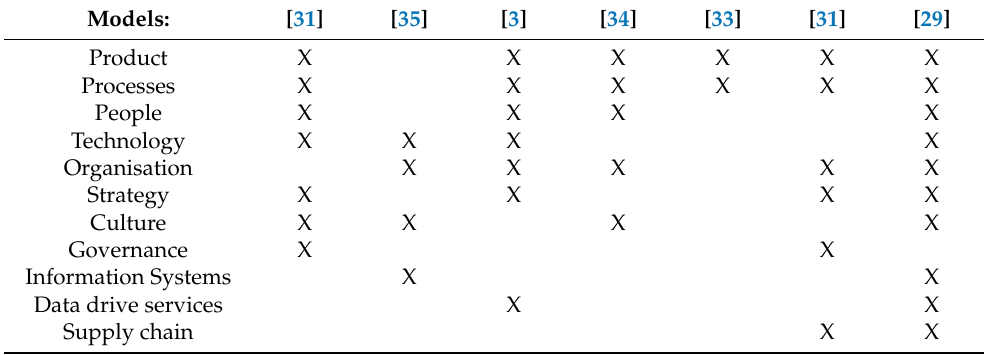
Table 2. I4.0 chosen models dimension